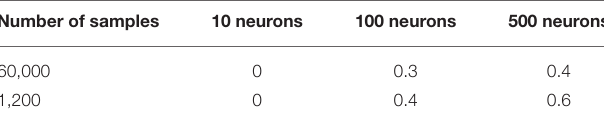
TABLE 1 | Dropout rates for different numbers of training samples and network sizes for the MNIST dataset. Number of samples 10 neurons 100 neurons